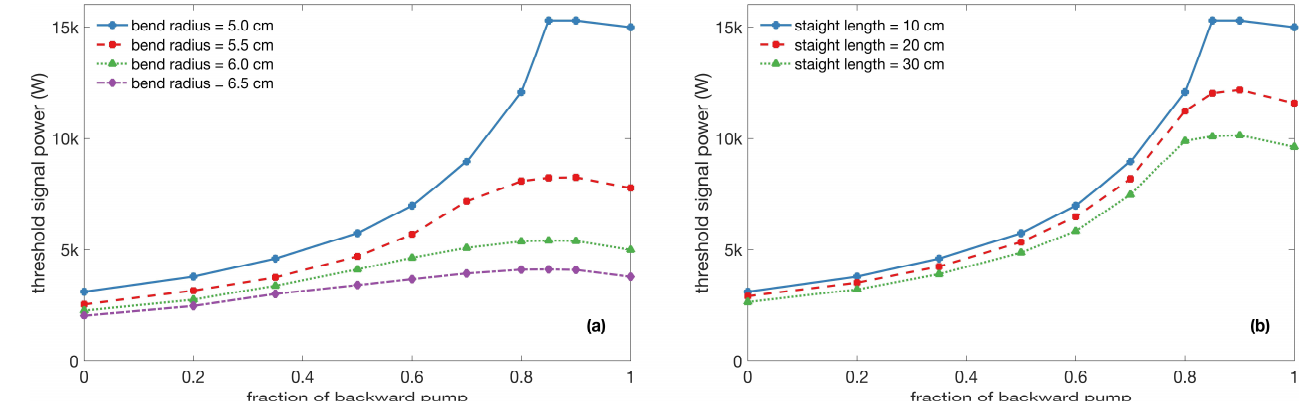
Figure 2. Transverse mode instability (TMI) thresholds under ( a ) different coiling radii (with a 10 cm straight length) and ( b ) different straight lengths (with a bend radius of 5 cm) with a different fraction of backward power.